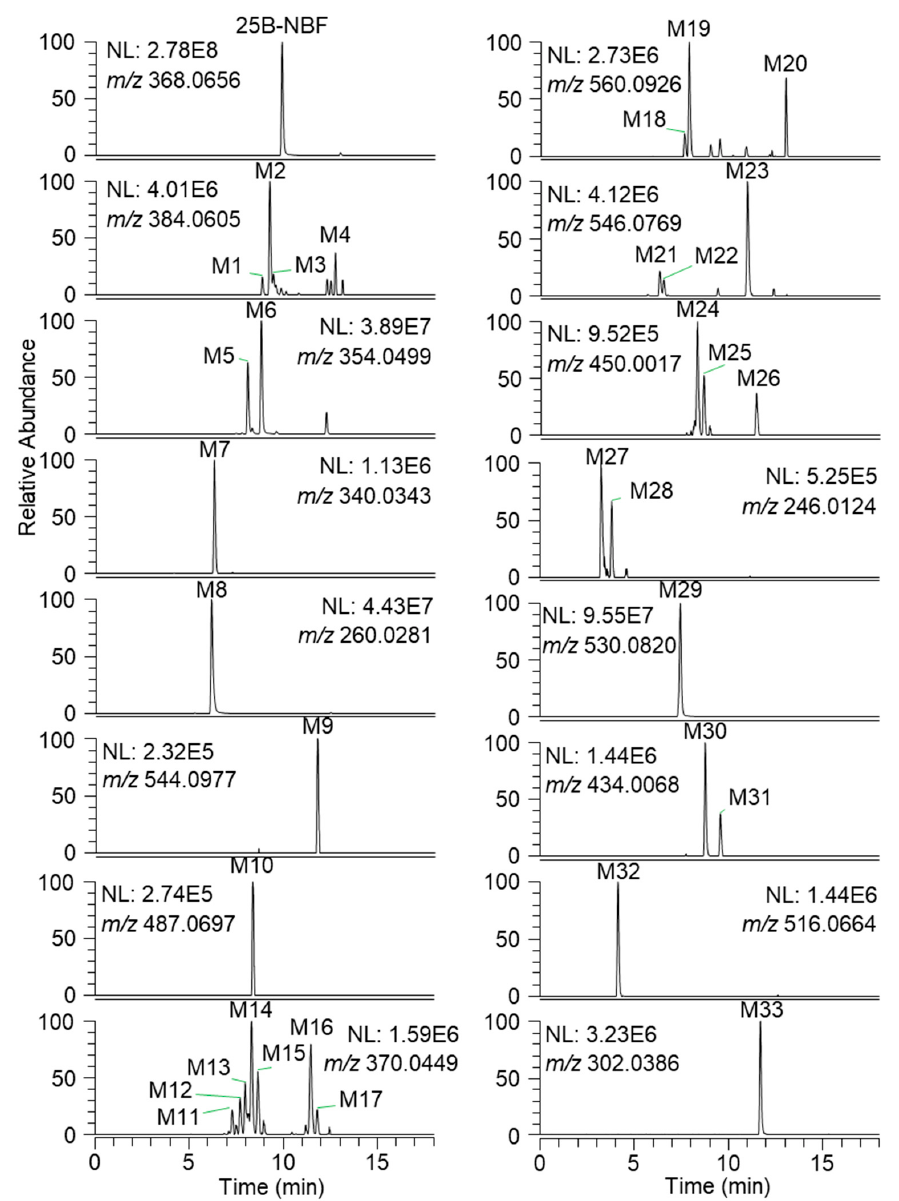
Figure 2. Representative extracted ion chromatograms of 25B-NBF and 33 metabolites identified after incubation with human hepatocytes for 2 h at 37 °C in a CO 2 incubator.